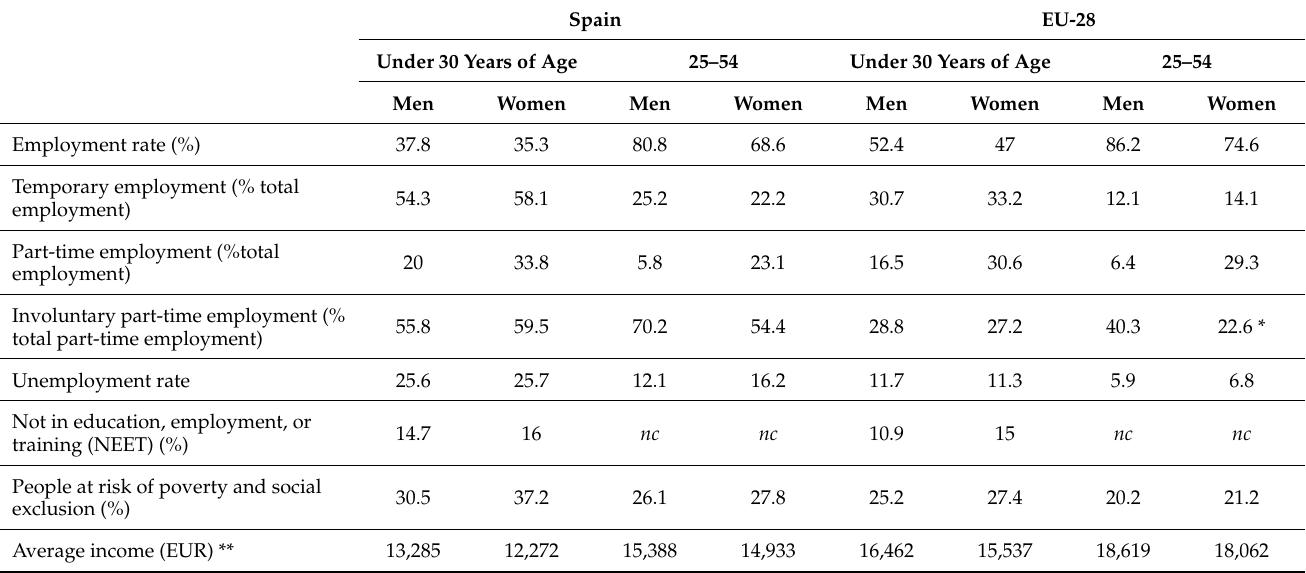
Table 1. Population by type of employment and by age in Spain and the EU-28, 2018.